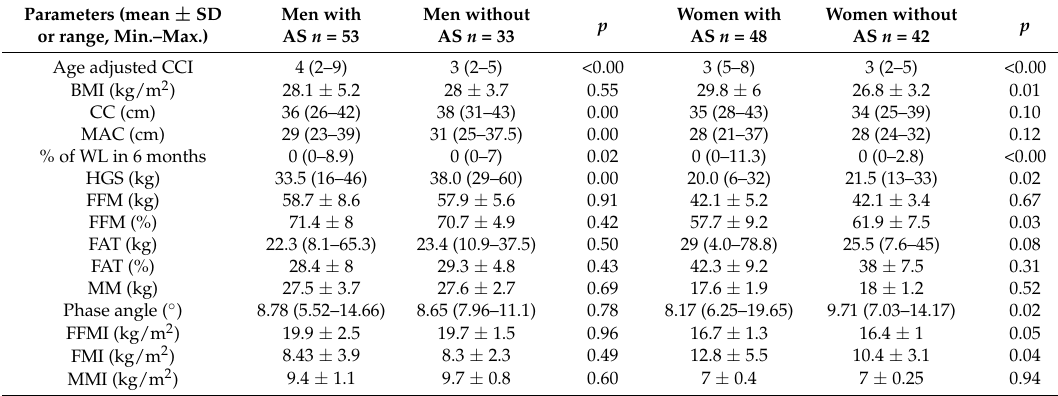
Table 4. The comparison of anthropometric measurements and body composition parameters in AS and control